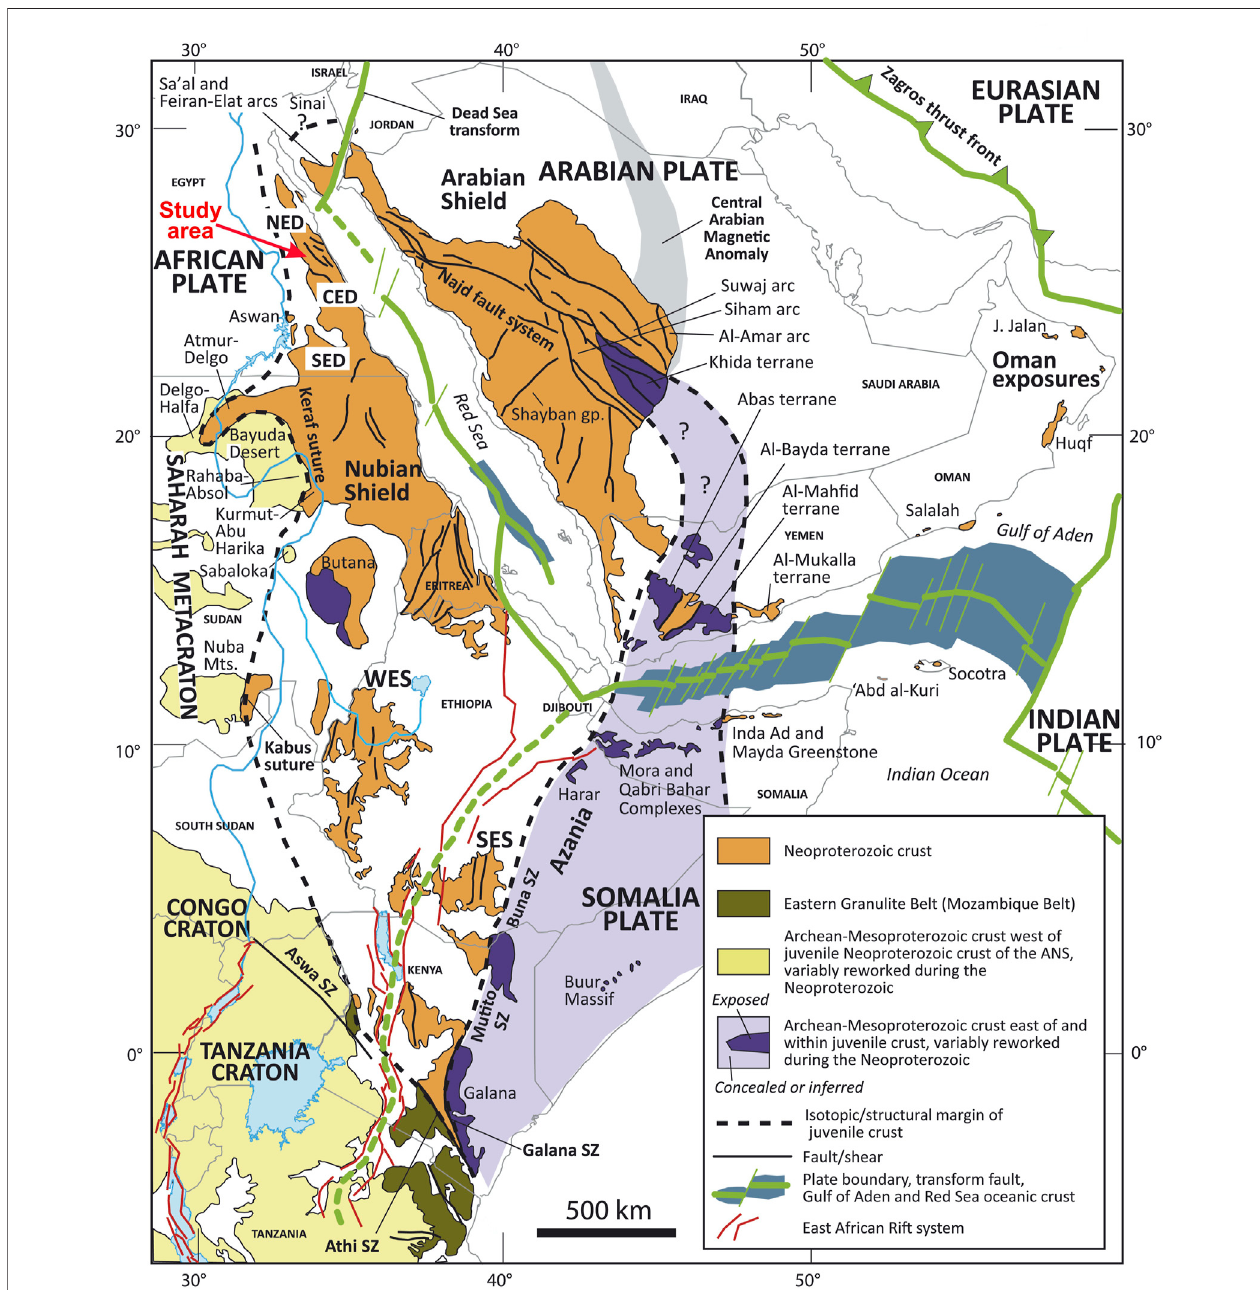
FIGURE 1 | Map of Northeast Africa and the Arabian Peninsula showing the distribution of juvenile Neoproterozoic crust and adjacent regions of Archean- Mesoproterozoic crust(afterFritzetal.,2013)and Cenozoicplate boundaries, RedSea-GulfofAdenspreadingcenters,andtheEastAfricanRift system(after Johnson, 2021). CED = Central Eastern Desert; NED = North Eastern Desert; SED = South Eastern Desert; SES = South Ethiopian shield; WES = West Ethiopian shield.